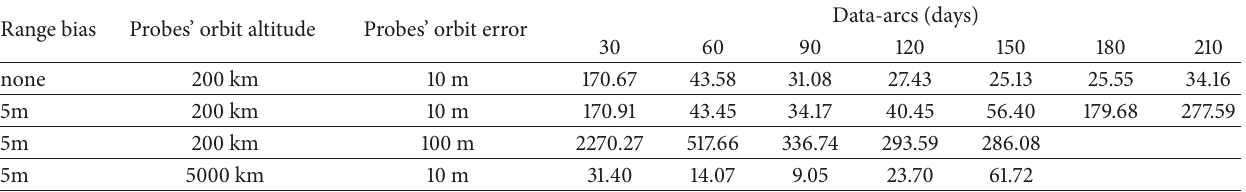
Table 6: Position precision of the Martian ephemeris short term prediction (unit: m).